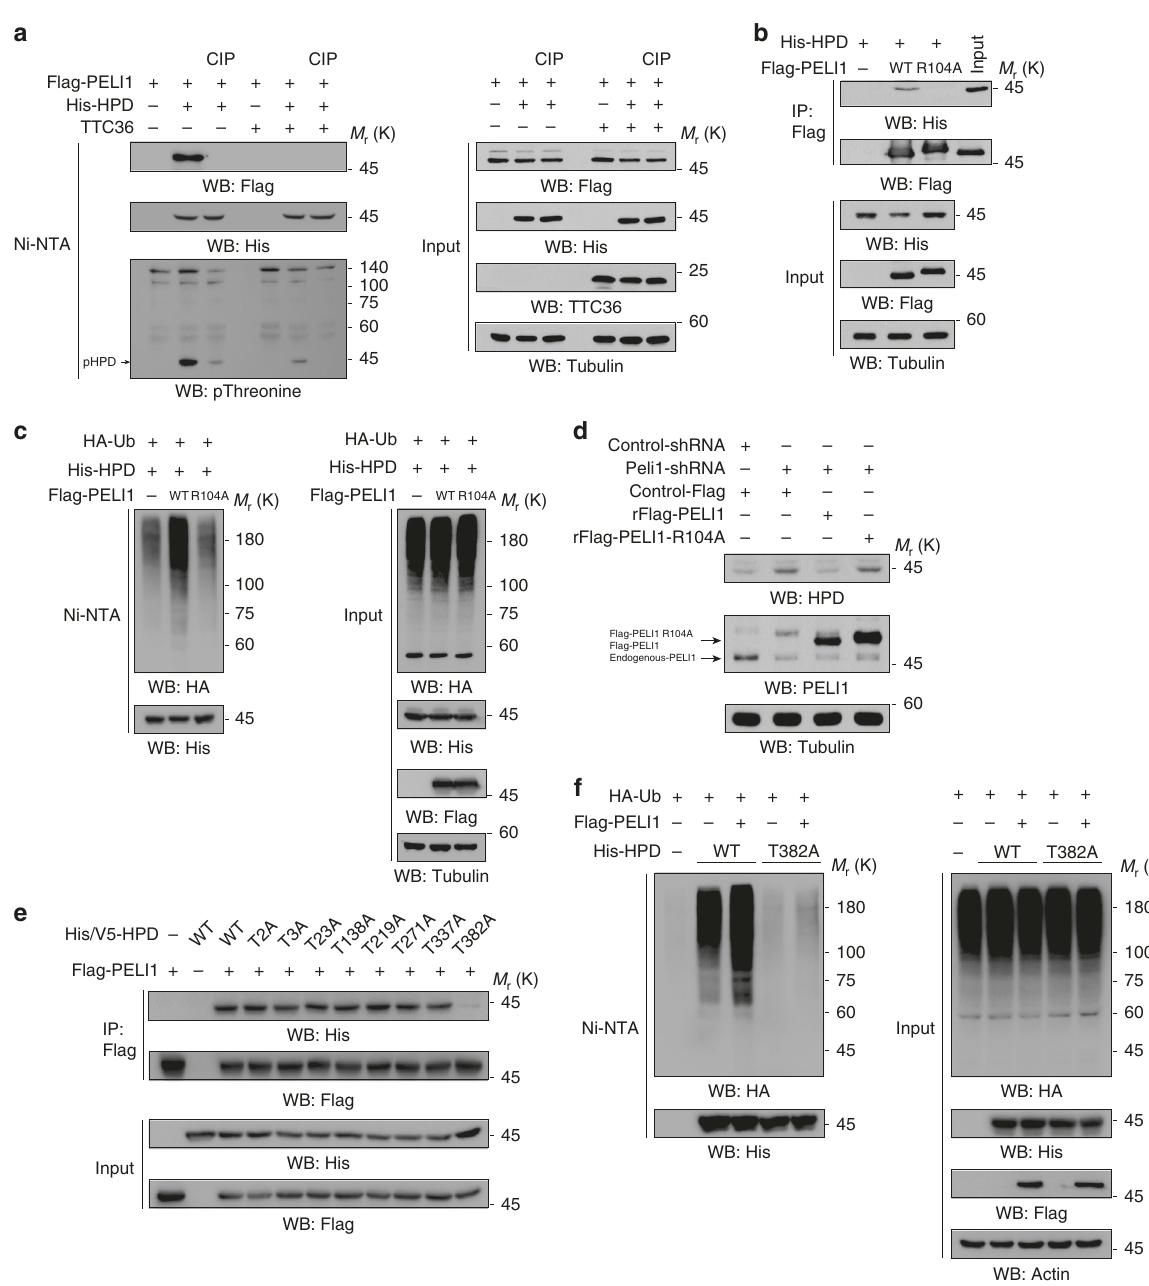
NATURE COMMUNICATIONS| (2019) 10:4266